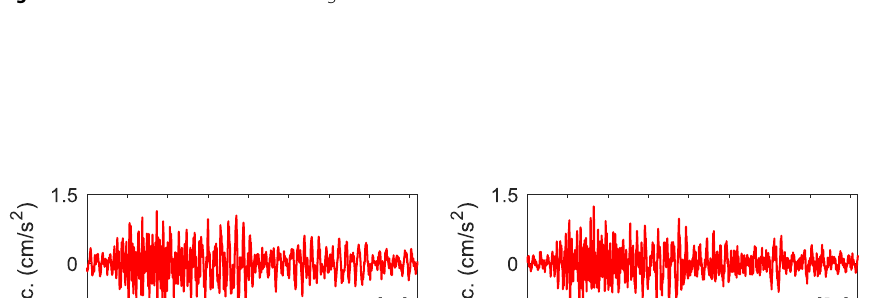
Fig. 9 Elevation view of the Jiuzhou bridge